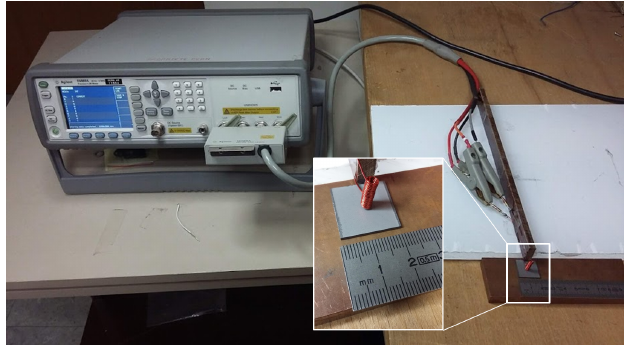
Figure 10. ECT setup. The impedance analyzer is connected to a coil suspended over a sample under